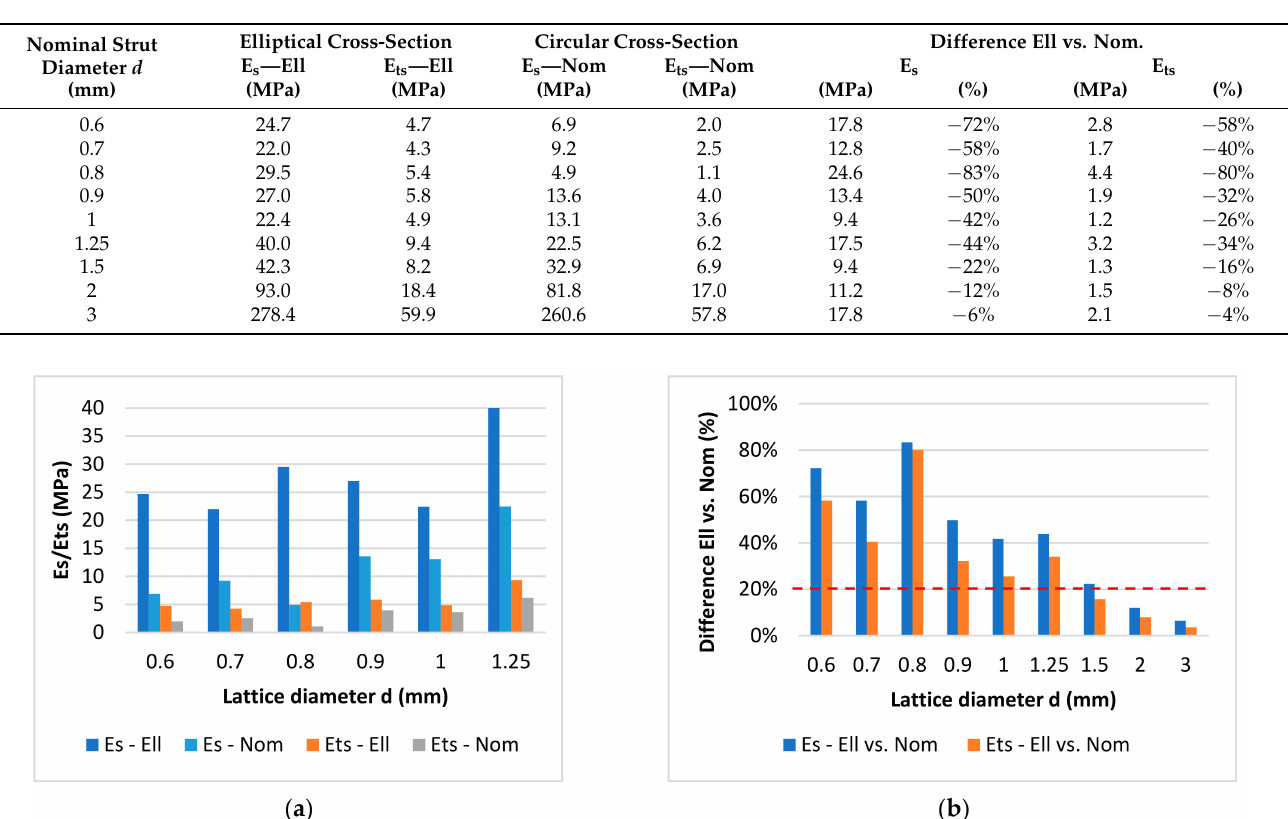
Table 7. The complete results of FEAs, using an elliptical and circular (nominal) cross-section of the lattice structure.